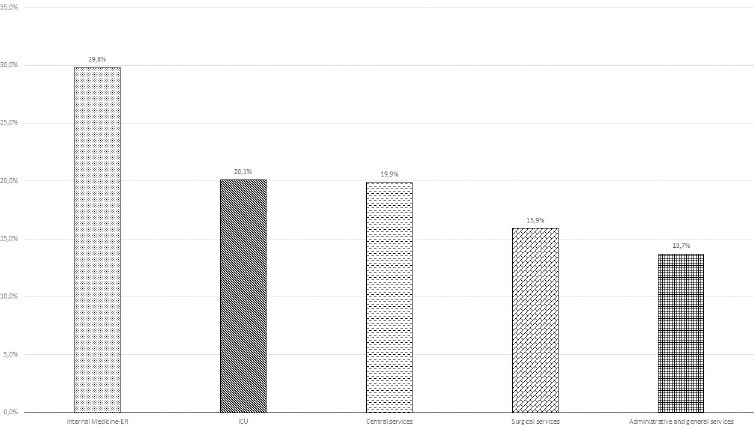
PLOS ONE | https://doi.org/10.1371/journal.pone.0245001 January 14,